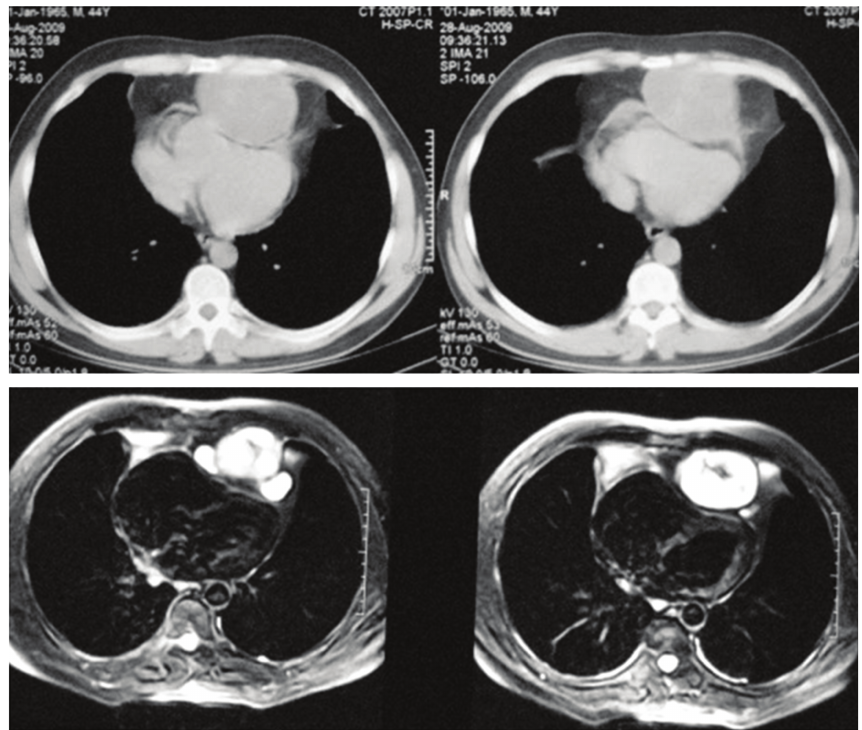
F 2: orax CT and MRI showing the large, encapsulated, well-de�ned anterior mediastinal mass lesion. e mass lesion was obviously compressing the